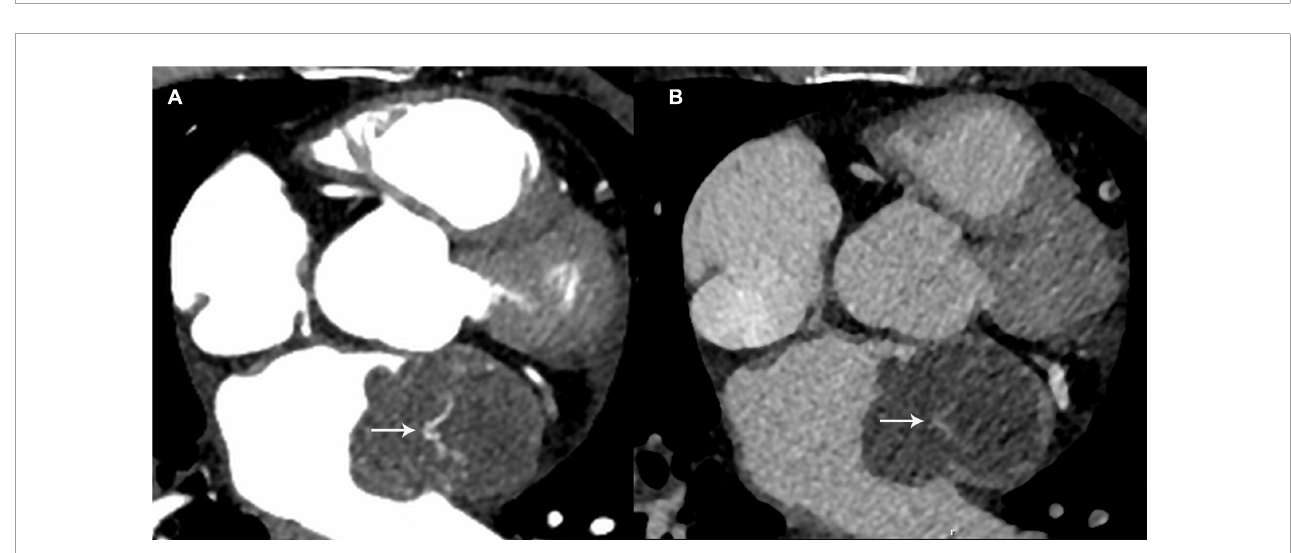
FIGURE2 The mass showed heterogeneous enhancement at the arterial phase (A) white arrow and the contrast uptake decreased with a longer delay time (B) white